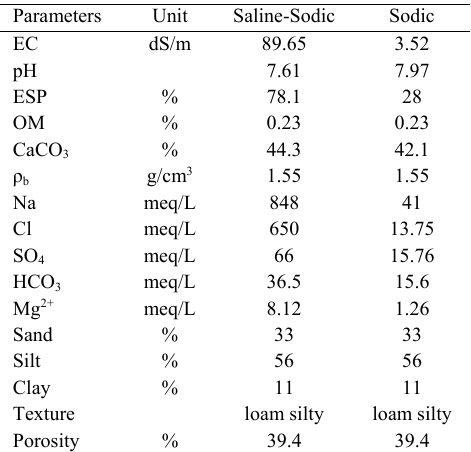
Table 1: Physicochemical properties of soils